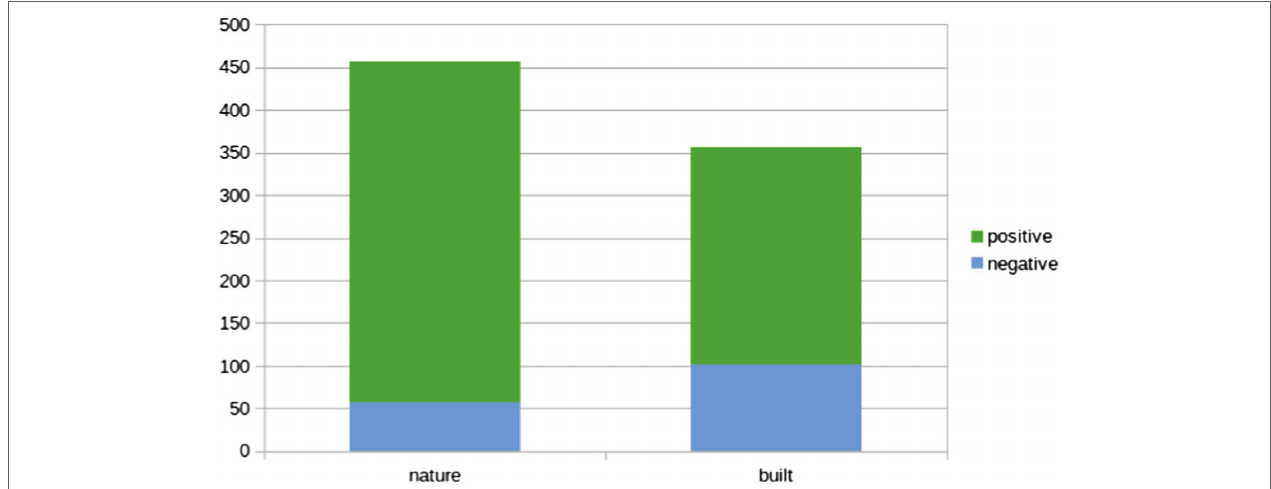
FIGURE 1 | Ratios of positive and negative emotions reported for nature vs. built